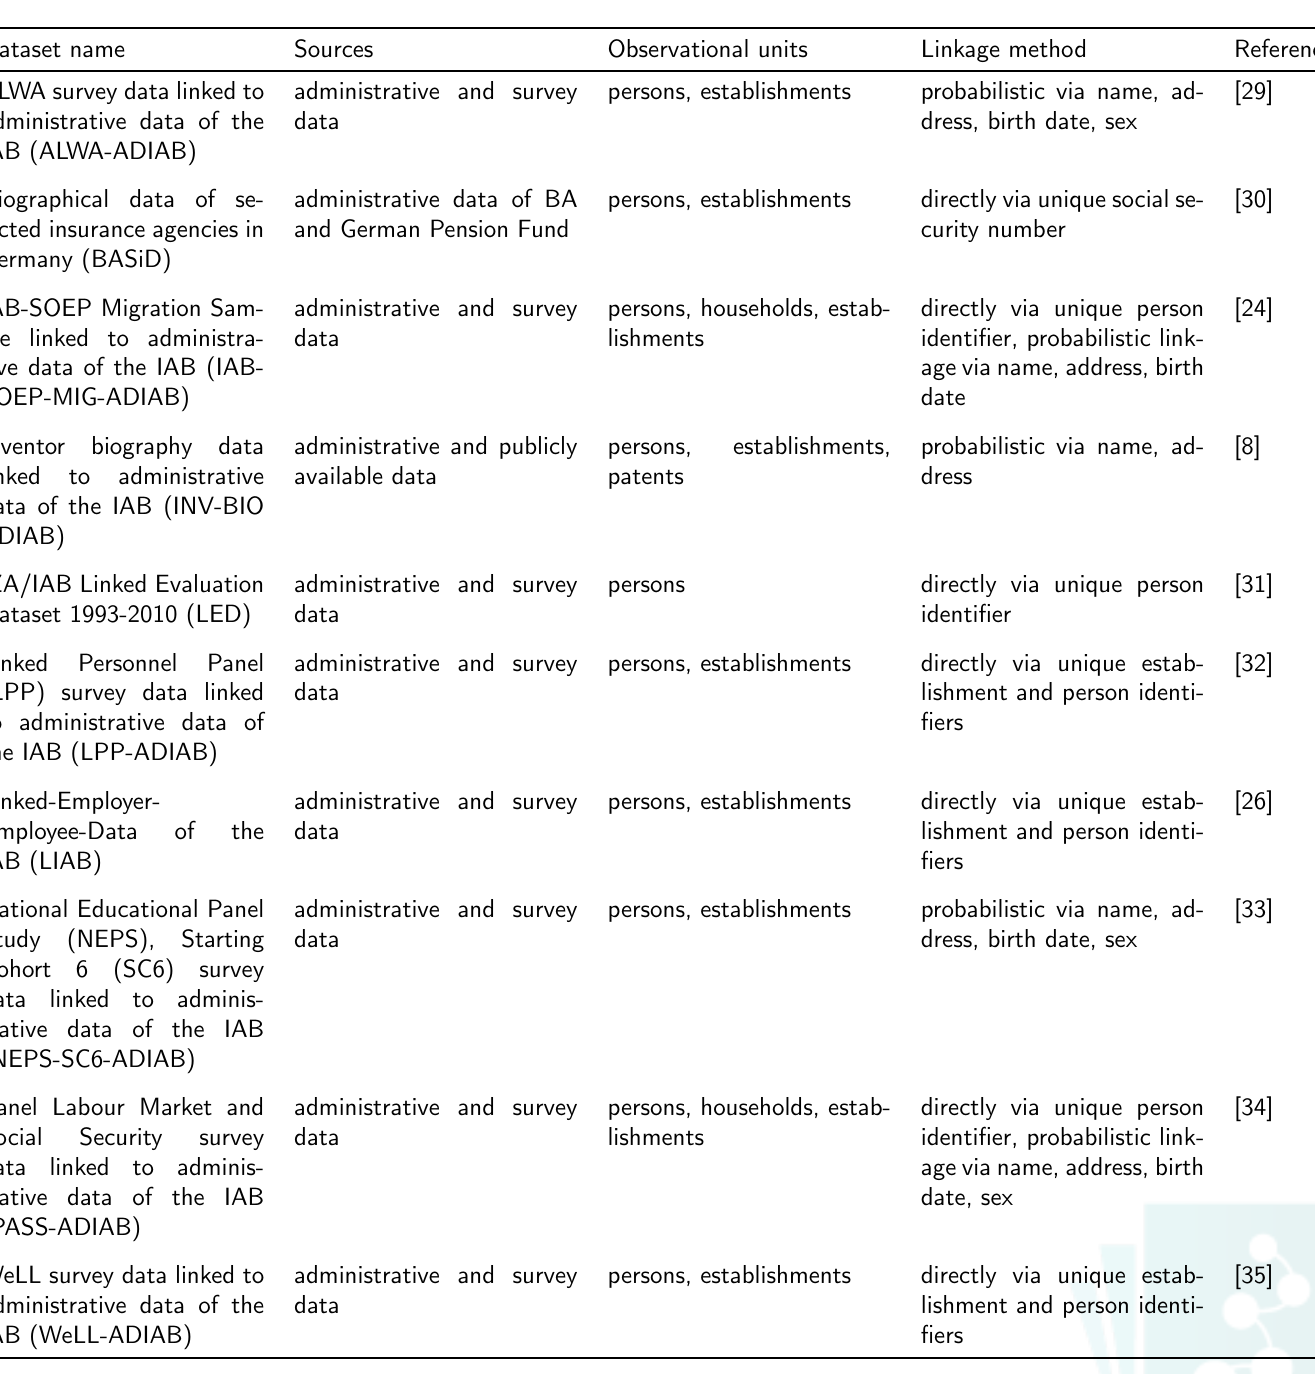
Table 1: Overview of linked data products of the